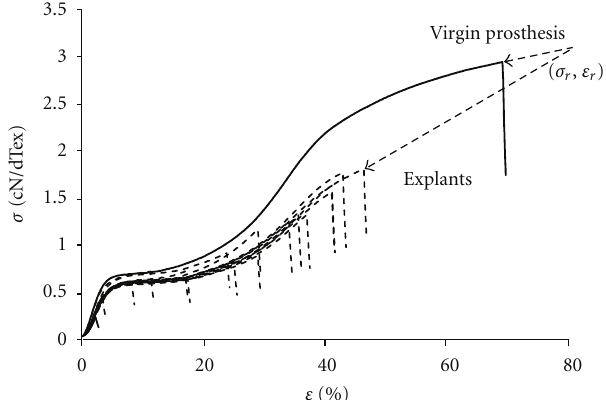
Figure 8: Classical dynamometry for various vascular prostheses.